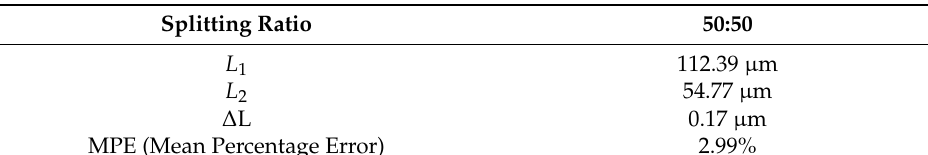
Table 1. MZDC design parameters.